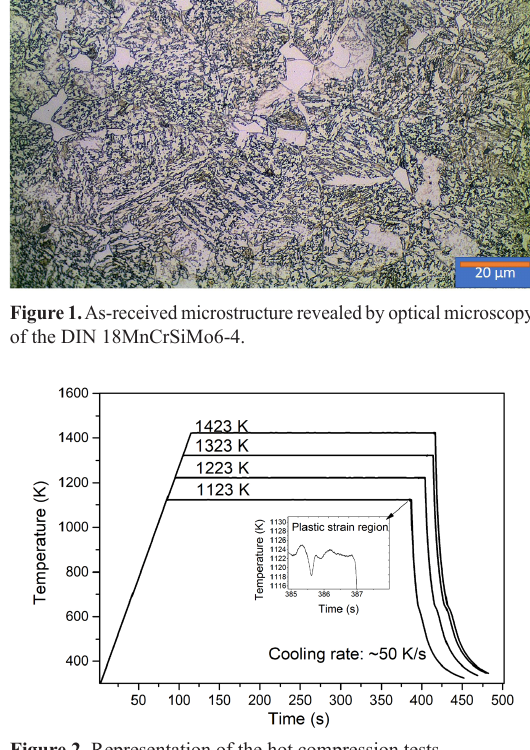
Figure 2. Representation of the hot compression